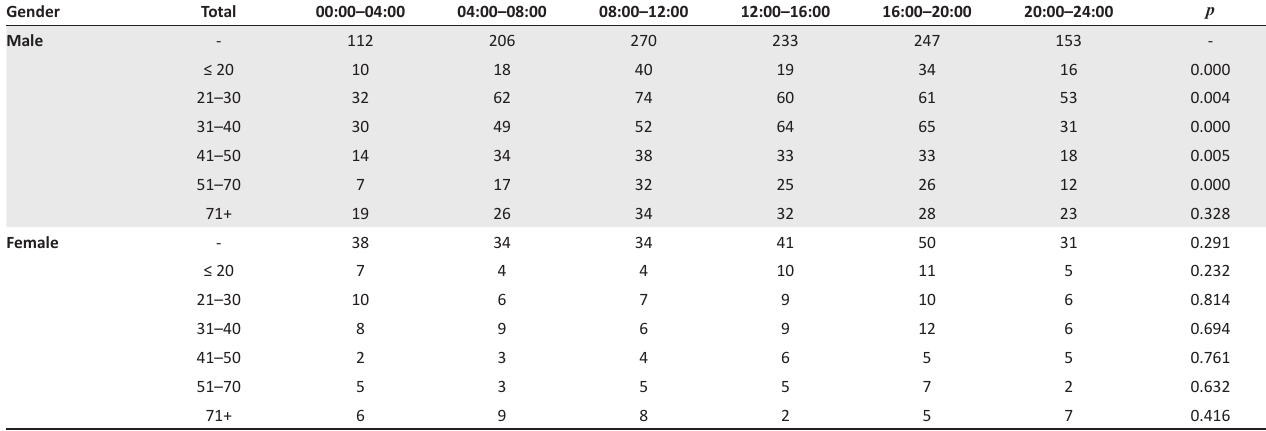
TABLE 3 : Distribution of most common suicide by time of day across gender and age.